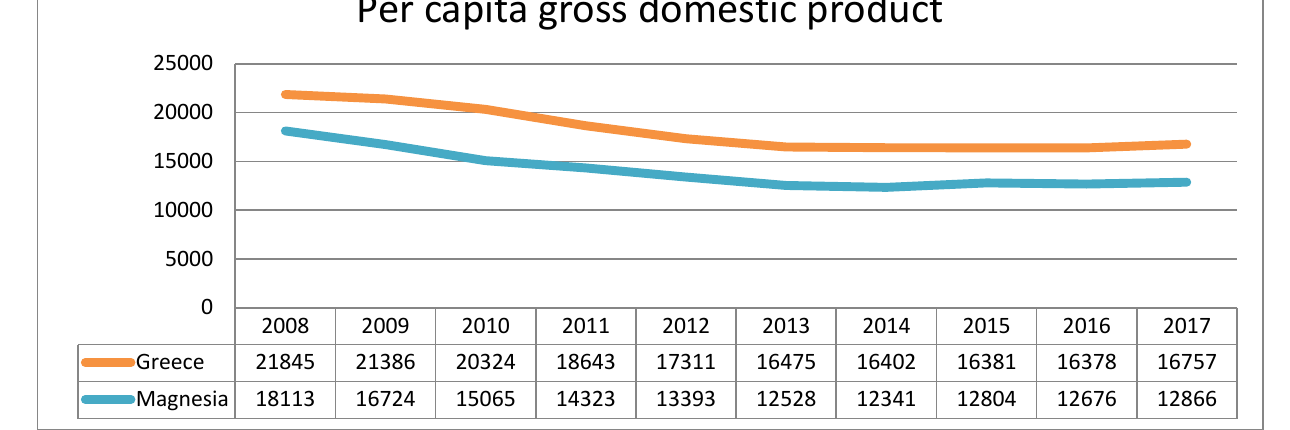
Figure 1. Per capita gross domestic product. Source: [44] , Own editing.